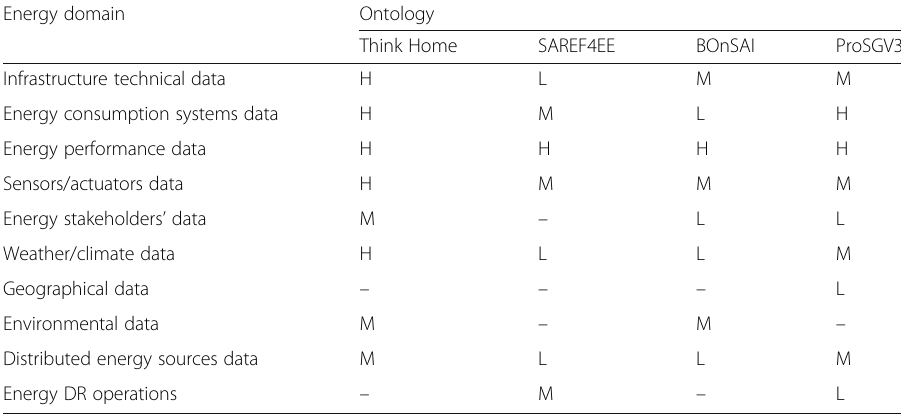
Table 2 Energy Domains Representation Level of Detail (Cuenca et al. 2017)